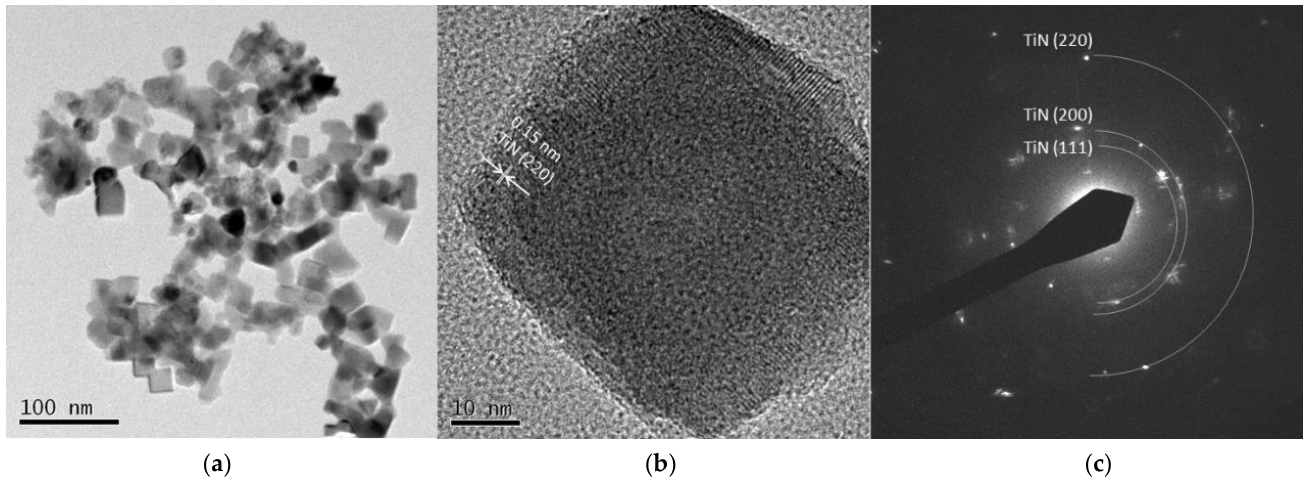
Figure 6. TEM images of Ti 30 A particles ( a ) low resolution image; ( b ) high resolution image; ( c ) SAED pattern. Al 5 A and Al 30 A